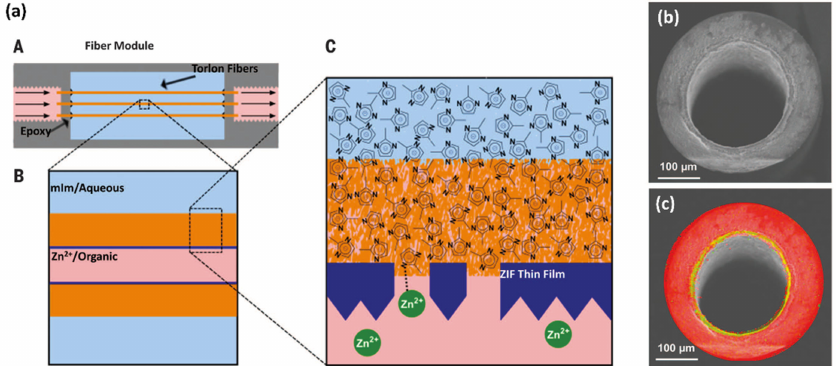
Figure 7. ( a ) Scheme showing the interfacial microfluidic membrane processing (IMMP) approach for ZIF membranes in hollow fibers. ( b ) Cross-section SEM and ( c ) EDX characterization of ZIF-8/hollow fiber membrane morphology and thickness. EDX elemental maps of carbon (red) and zinc (green) showing the localization of the ZIF-8 membrane on the inner surface of the fiber